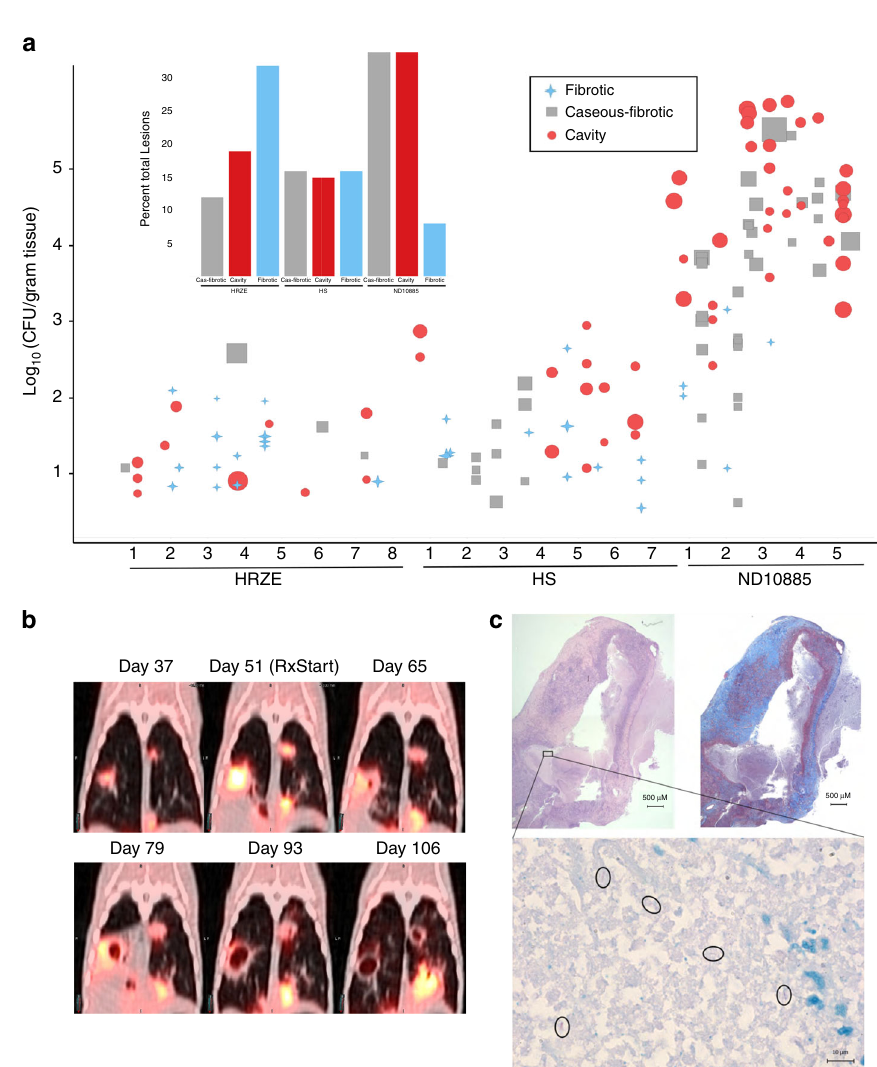
Fig. 3 ND10885 treatment in infected marmosets allows cavity formation. a Lesion pathology at necropsy for marmosets treated with three different drug regimens. HRZE, isoniazid, rifampicin, pyrazinamide, and ethambutol; HS, isoniaizid, and streptomycin (CFU data and PK have been previously published for both control arms; ref. 28 ). Each number refers to an individual animal and each symbol above it describes the pathology of each individual lesion within that animal, the size of the symbol is according to the size of the lesion, small symbols are 1 mm lesions and the largest symbols are ~10 mm lesions. The inset bar graph summarizes the same data according to the total percentage of lesions in each of the three pathology types. Source data are provided as a Source Data fi le. b an example of PET/CT images of one animal treated with ND10885 over time, the fi rst image is 37 days after infection with a low-dose aerosol of M. tuberculosis , the second image is day 51 and immediately after that image the animal began receiving ND10885. There are two lesions, one on the right and one on the left that progressively cavitate and expel their contents. c Pathology images of one of these cavities showing on the top left the H&E stained slice and on the right the Masson ’ s Trichrome stain to illustrate the fi brous cavity wall. In both panels the scale bar is 500 μ m. The small black box in the H&E slice is shown at ×100 with a 10- μ m scale bar with acid-fast staining showing the presence of multiple individual bacilli